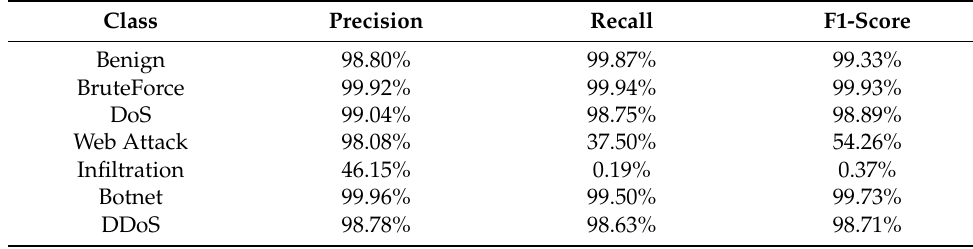
Table 24. LSTM evaluation results for multi-class